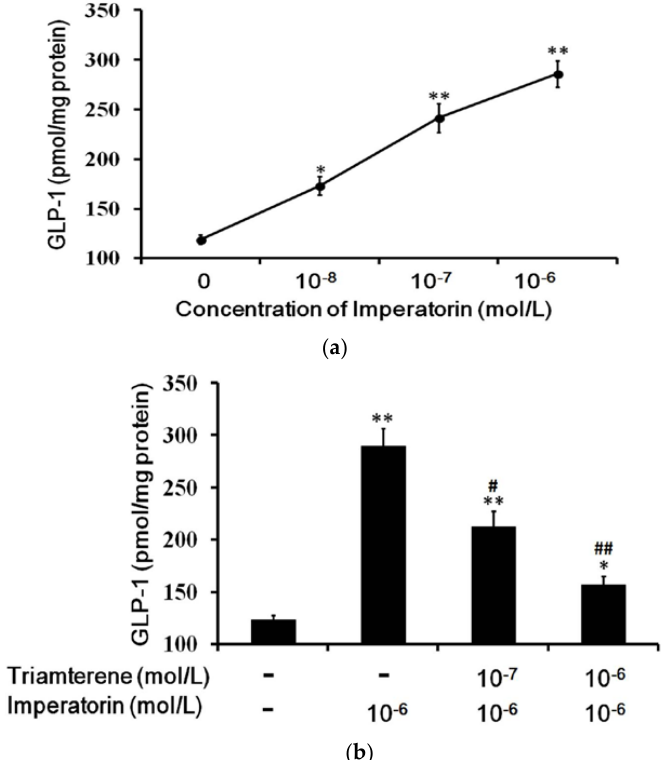
Figure 3. Increased GLP-1 secretion induced by imperatorin in NCI-H716 cells. ( a ) Imperatorin markedly induced GLP-1 secretion. ( b ) Triamterene dose-dependently inhibited imperatorin-induced GLP-1 secretion in NCI-H716 cells. Values (mean ± SEM) were obtained from eight measurements in each group. * p < 0.05 and ** p < 0.01 compared with the vehicle-treated group (basal value). “-” is presented as 0 mol/L. # p < 0.05 and ## p < 0.01 compared with the vehicle-treated, imperatorin-stimulated group (second column).